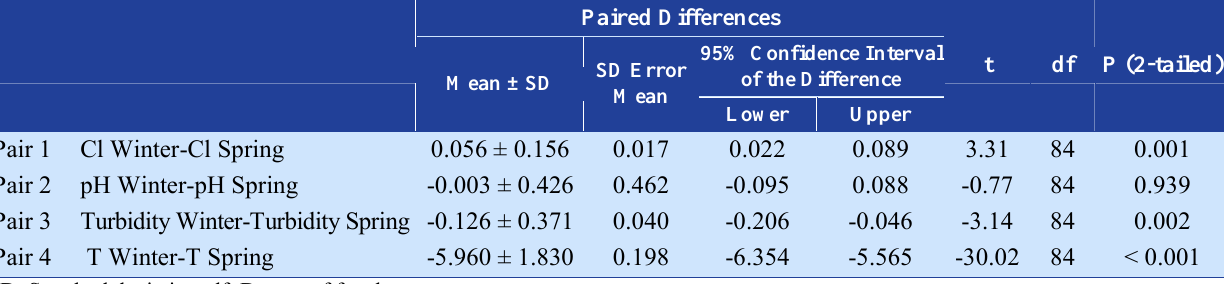
Table 1. The results of the Pearson